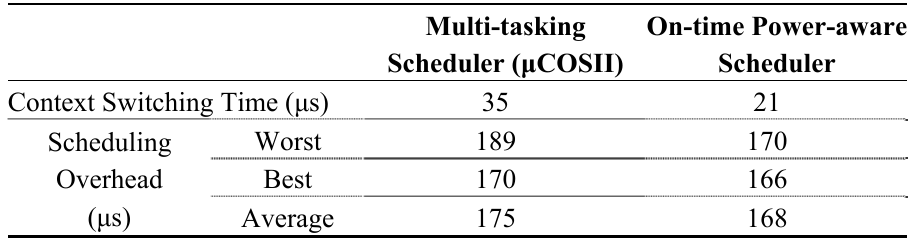
Table 3. Comparison of scheduling latencies.